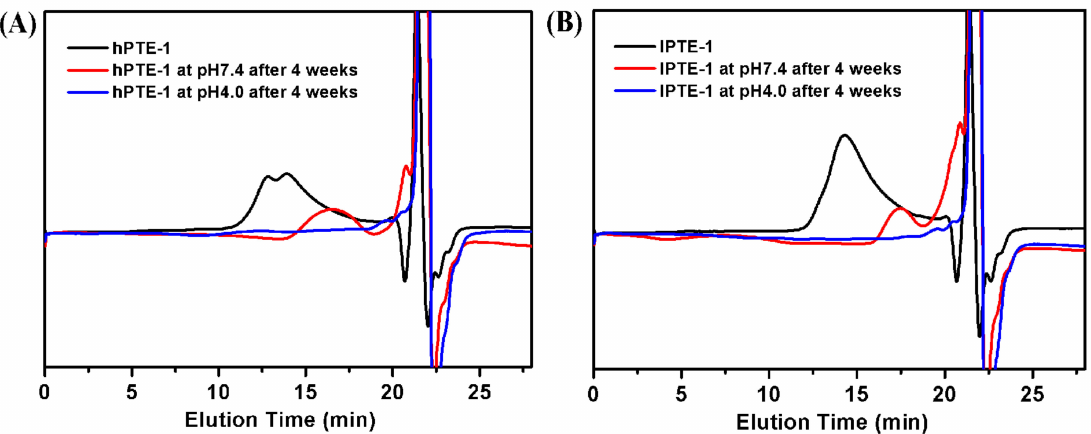
Figure 6. GPC traces of the degradation products of hPTE-1 ( A ) and lPTE-1 ( B ) at pH 7.4 and pH